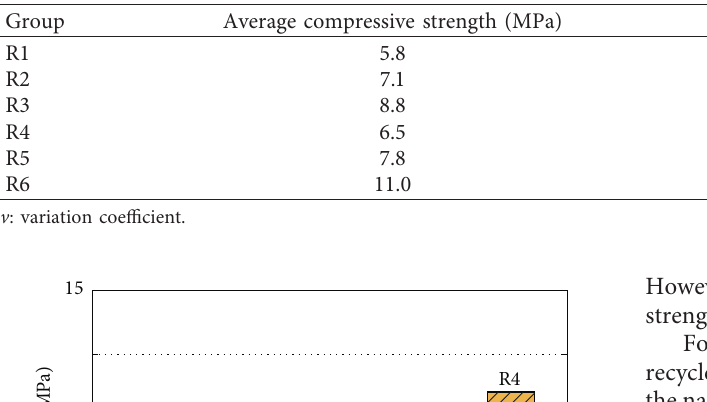
Table 4: Mixture proportions of RCB.